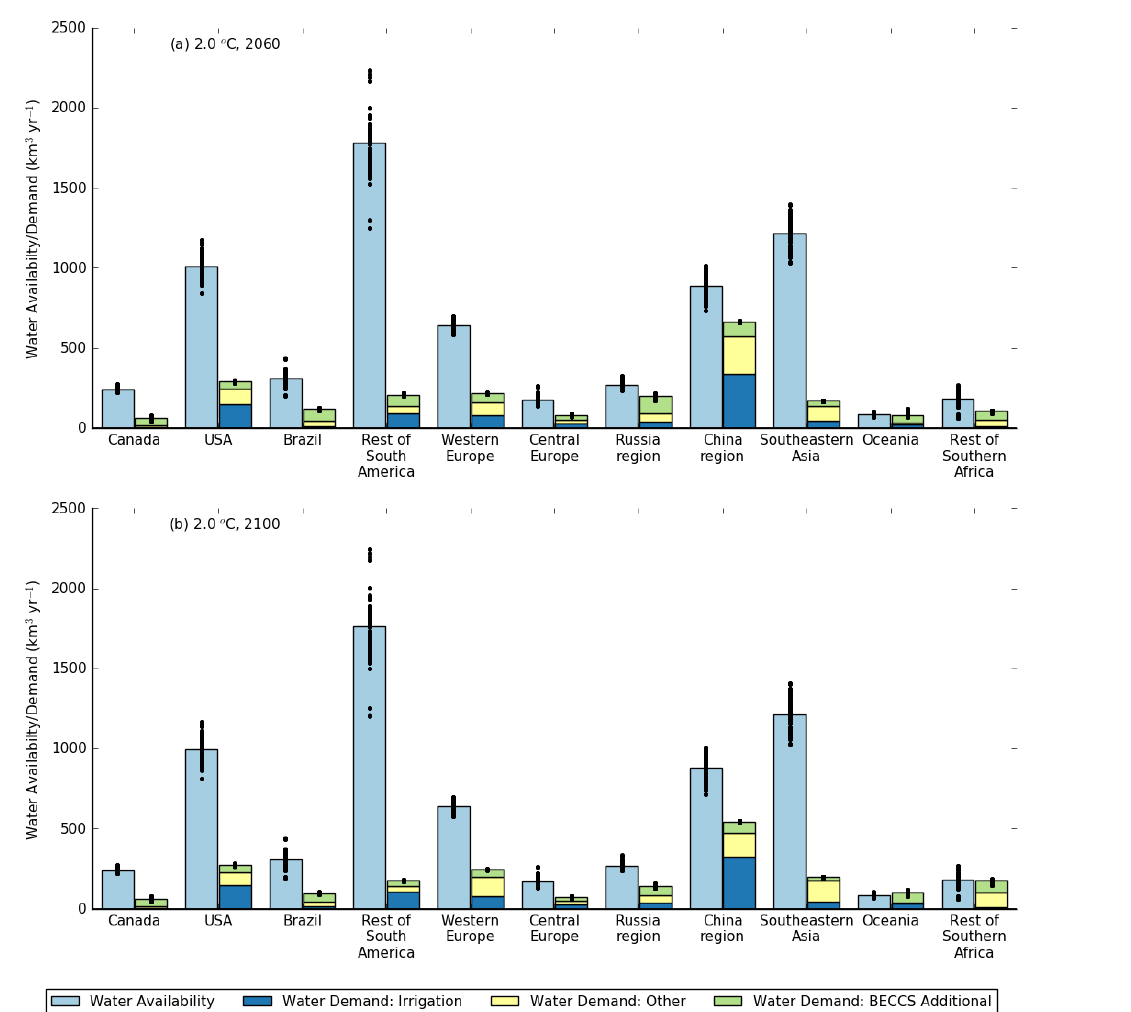
Figure 14. Water availability (light blue), SSP2-IMAGE water demand estimates for irrigation (dark blue), other uses (i.e. energy generation, industry, and domestic; yellow), and the additional water demand from BECCS (green) for the years 2059–2060 and 2099–2100 for the 2.0 ◦ C warming target, with a BECCS κ factor of 3. The points are the individual results from the 136-member ensembles, while the bars are the corresponding median values of the